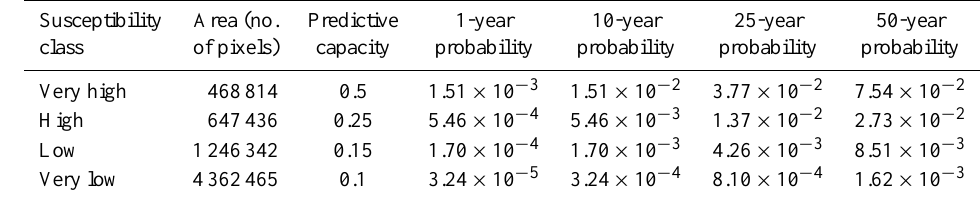
Table 5. Probability of occurrence of deep-seated landslides in 1, 10, 25, and 50 years in the Loures municipality. Susceptibility Area (no. Predictive of pixels) capacity probability probability probability probability Very high